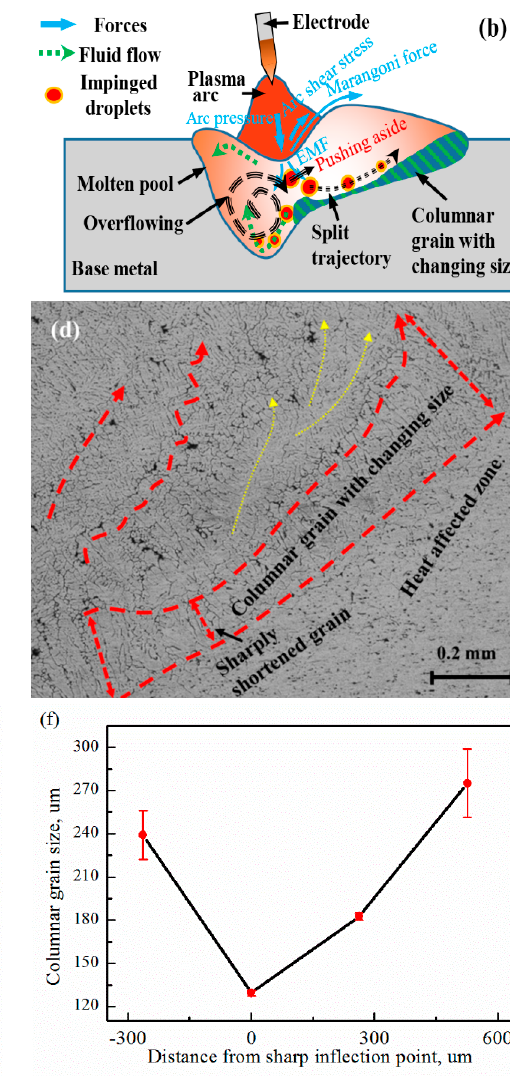
Figure 4. Welding torch inclined from the center line in the transverse section. ( a ) Molten pool profile; ( b ) schematic diagram of the molten pool behavior; ( c ) signs of downward flow; ( d ) signs of upward flow; ( e ) width, depth and width/depth ratio of the FLP; ( f ) columnar grain size along the upward wall.